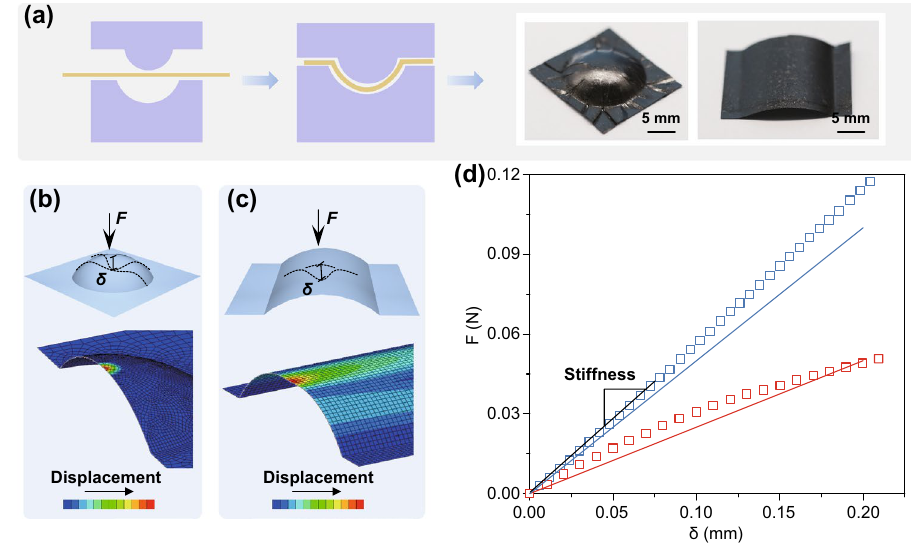
Fig. 4 a Thermoplastic forming process of Pi-GOS from flat papers into stereostructures with positive curvatures. b FEA simulation results of indentation test for spherical and c cylindrical shells molded of Pi-GOS with same thickness (32 μm). d Force–displacement curves of spherical shell (blue square points) and cylindrical shell (red square points). Solid lines correspond to the fitting results